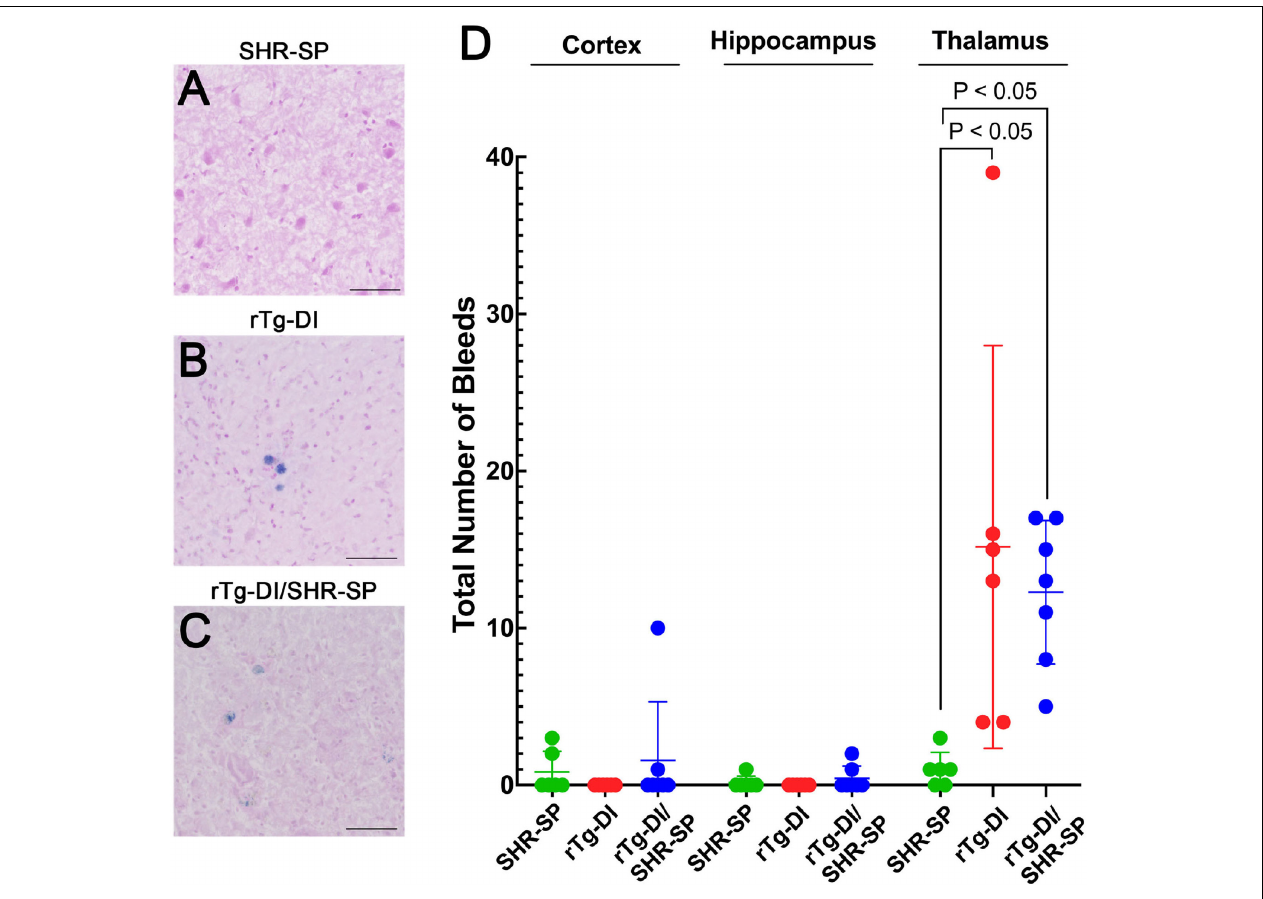
FIGURE 9 | Cerebral microbleeds in 10 M rats. Representative images of the thalamic region of 10 M old SHR-SP (A) , rTg-DI (B) , and bigenic rTg-DI/SHR-SP (C) stained with hemosiderin to identify cerebral microbleeds. Scale bars = 50 µ m. (D) Number of microbleeds in different brain regions are shown in SHR-SP ( n = 6) in green, rTg-DI ( n = 6) in red, and rTg-DI/SHR-SP ( n = 7) in blue. Data shown are means ± S.D. Significant differences are shown by one-way ANOVA between rTg-DI and SHR-SP ( P < 0.05) and between bigenic rTg-DI/SHR-SP and SHR-SP ( P < 0.05). These differences indicate a preservation of the microbleeding pattern observed in rTg-DI in bigenic rTg-DI/SHR-SP